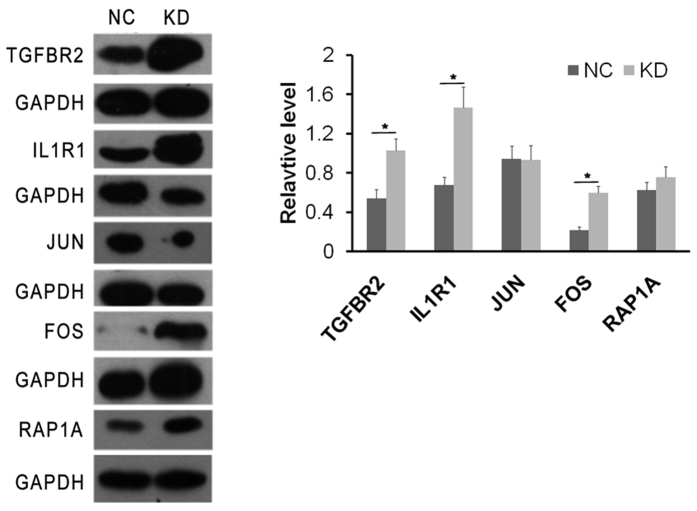
The effects of DDX51 knockdown on protein expression according to western blotting.GAPDH was used as a loading control. NC, negative control; KD, DDX51 knockdown. All results were reproducible in three independent experiments. *P < 0.05.